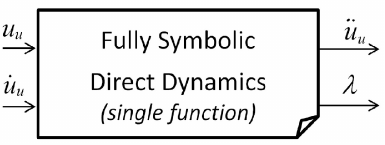
Figure 6. Fully symbolic generation of constrained MBS